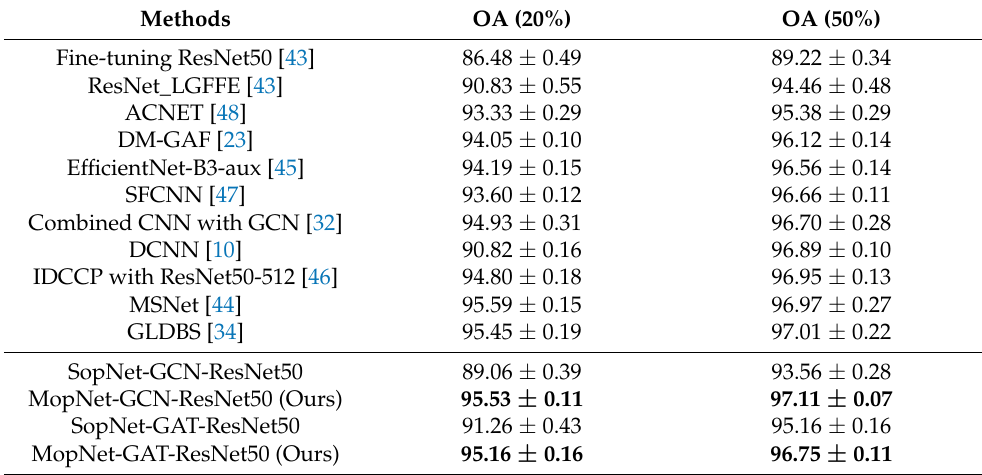
Table 4. Comparison of OAs (%) of different methods on the AID